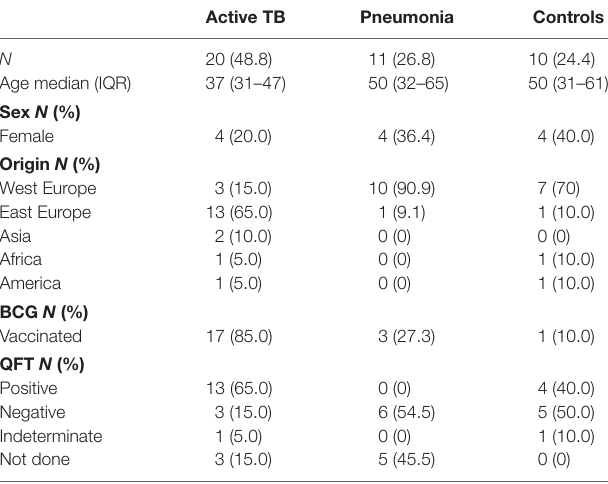
TaBle 1 | Baseline information of study